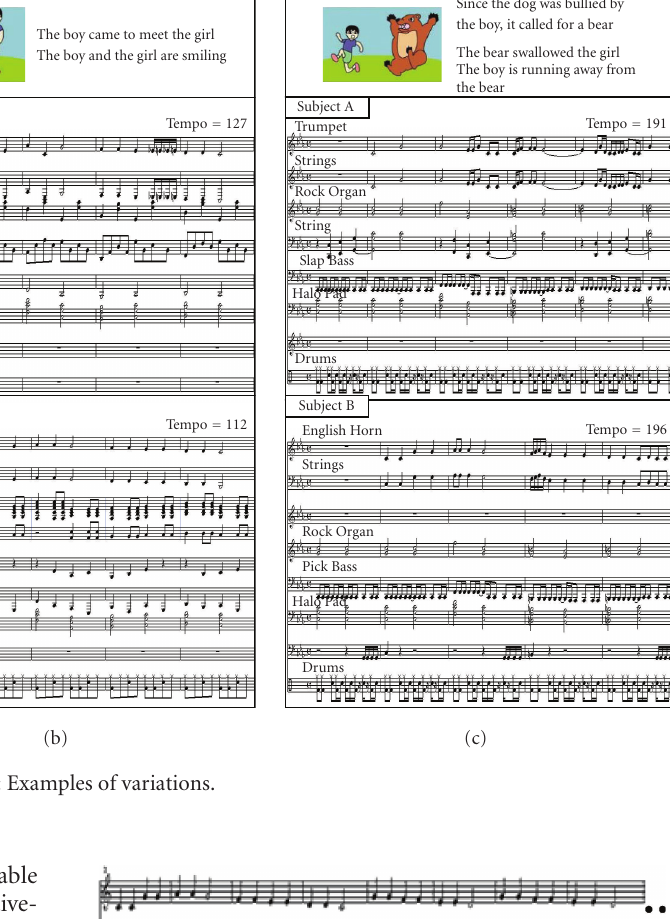
Figure 11: Theme